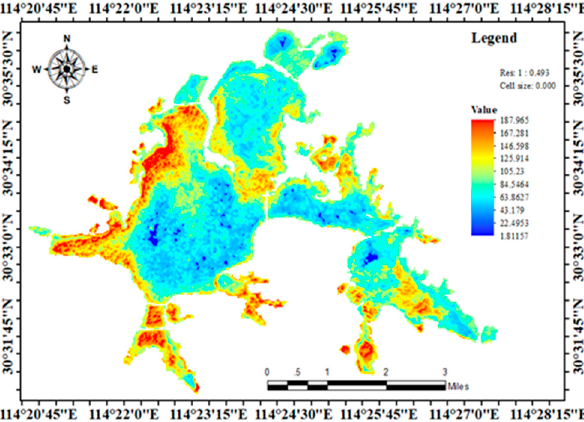
Figure 4. Chlorophyll a concentration inversion distribution on 15 November 2017 in Donghu Lake.